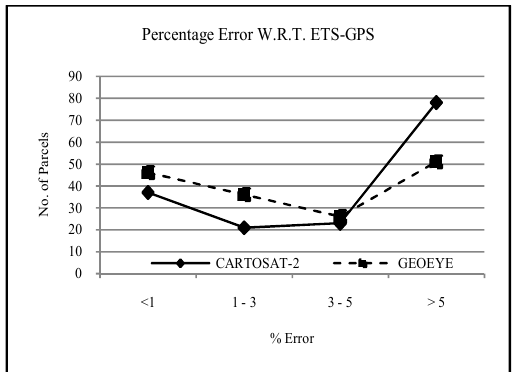
Figure 11. Plot of number of Parcels against the percentage error of Perimeter in CARTOSAT-2 and GEO-EYE with respect to ETS-GPS Survey When observed in Table 6, 29% Parcels (46 Parcels) derived from GEO-EYE had perimeter deviation less than 1% with respect to ETS-GPS which shows an accurate match between these two parcel layers. Around 23% Parcels (36 Parcels) derived from GEO-EYE had perimeter deviation between 1% and 3% w.r.t. ETS-GPS which shows a minimal mismatch between these two parcel layers. Around 16% Parcels (26 Parcels) derived from GEO-EYE had perimeter deviation between 3% and 5% w.r.t. ETS-GPS which indicates small mismatch between two layers. Also in case of CARTOSAT-2 23% Parcels (37 Parcels) have perimeter deviations less than 1%, 13% Parcels (21 Parcels) have perimeter deviations between 1% and 3%, 15%